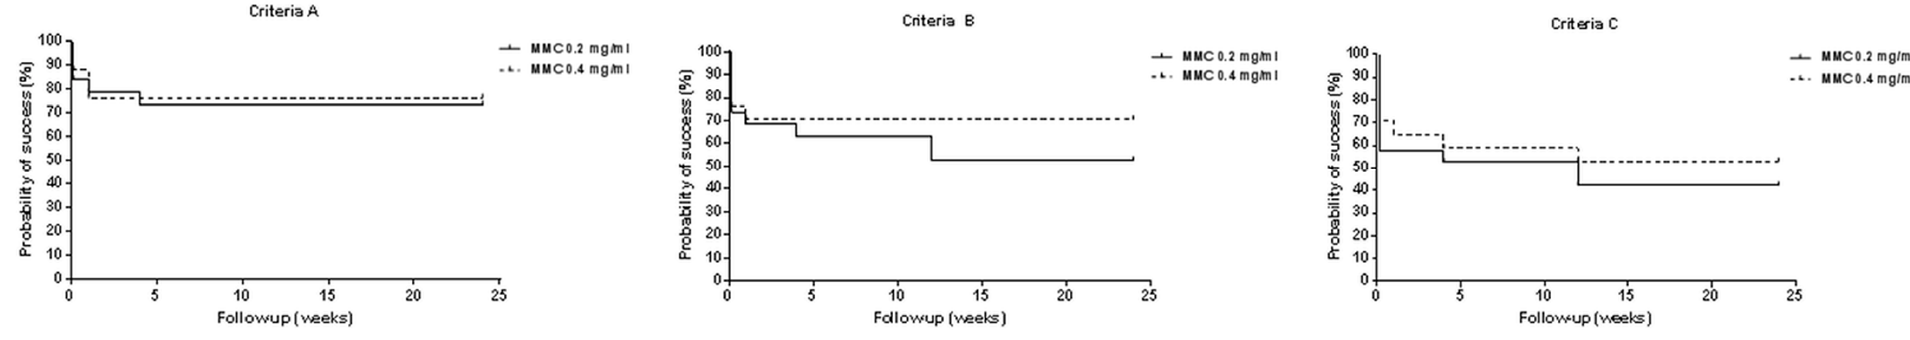
Figure 2. Kaplan–Meier estimates for surgical success according to three criteria for success. Criteria A (intraocular pressure (IOP) ≤ 18 mmHg and IOP reduction ≥ 20%), B (IOP ≤ 15 mmHg and IOP reduction ≥ 25%), C (IOP ≤ 12 mmHg and IOP reduction ≥ 30%).